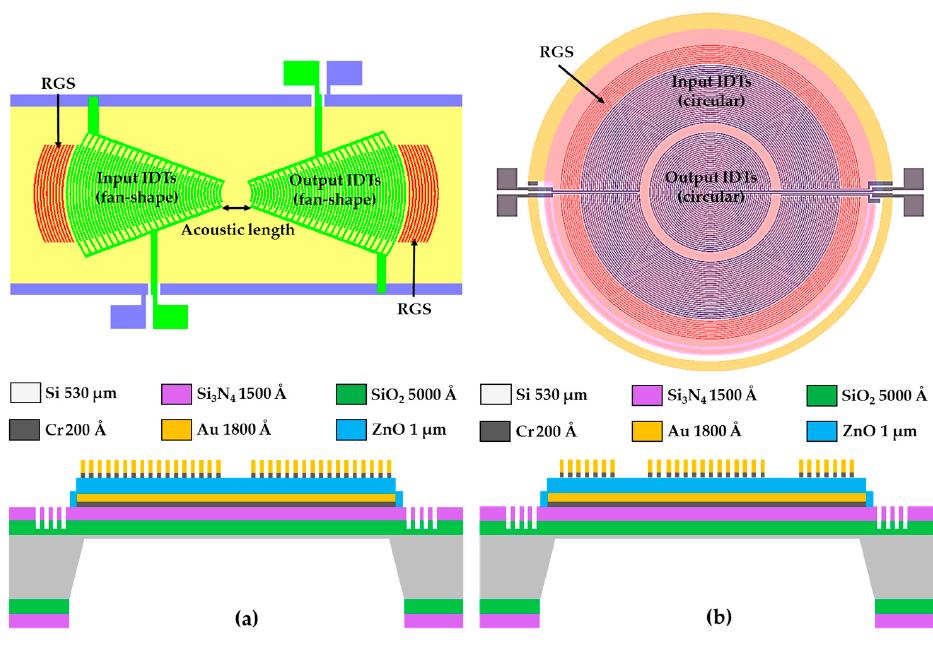
Figure 2. Layout diagram and cross-sectional structure of the presented FPW devices with ( a ) fan-shaped and ( b ) circular IDTs and a Si-groove RGS. Table 1. Design specifications of the fan-shaped and circular IDTs/RGS configurations.